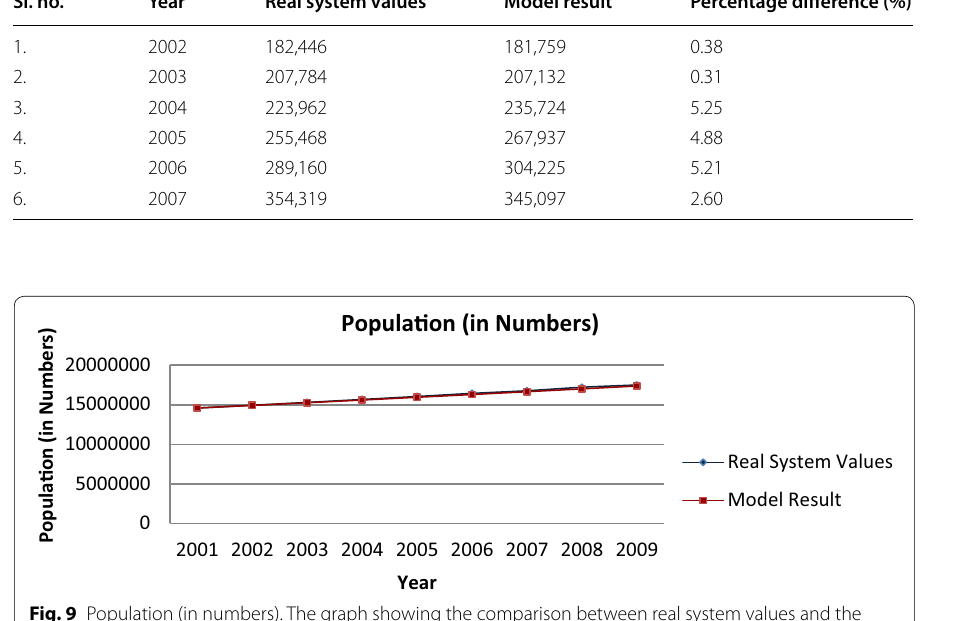
Fig. 9 Population (in numbers). The graph showing the comparison between real system values and the model generated values from the year 2001 to 2009. The line in blue colour represents the real system values, and the line in red colour shows the model values of population growth trend